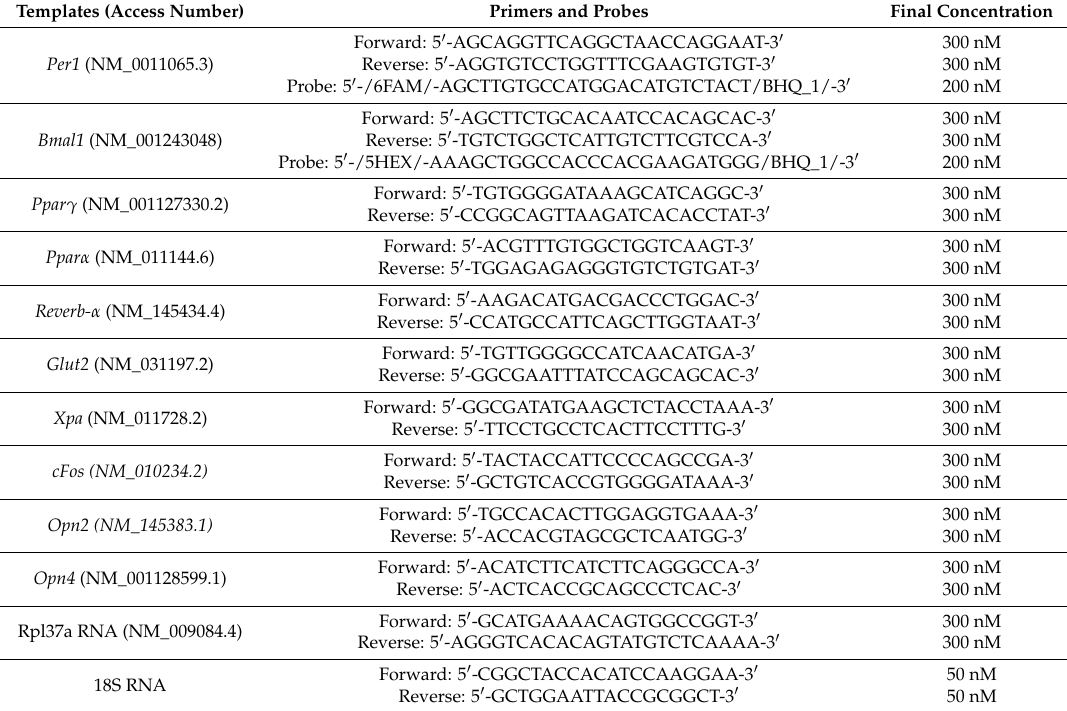
Table 3. Sequences and concentrations of primers and probes, and gene access